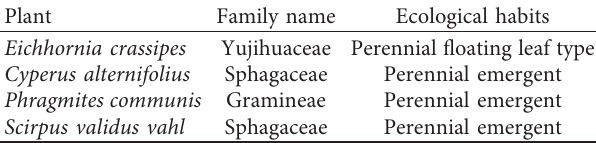
Table 1: Test plant species and growth